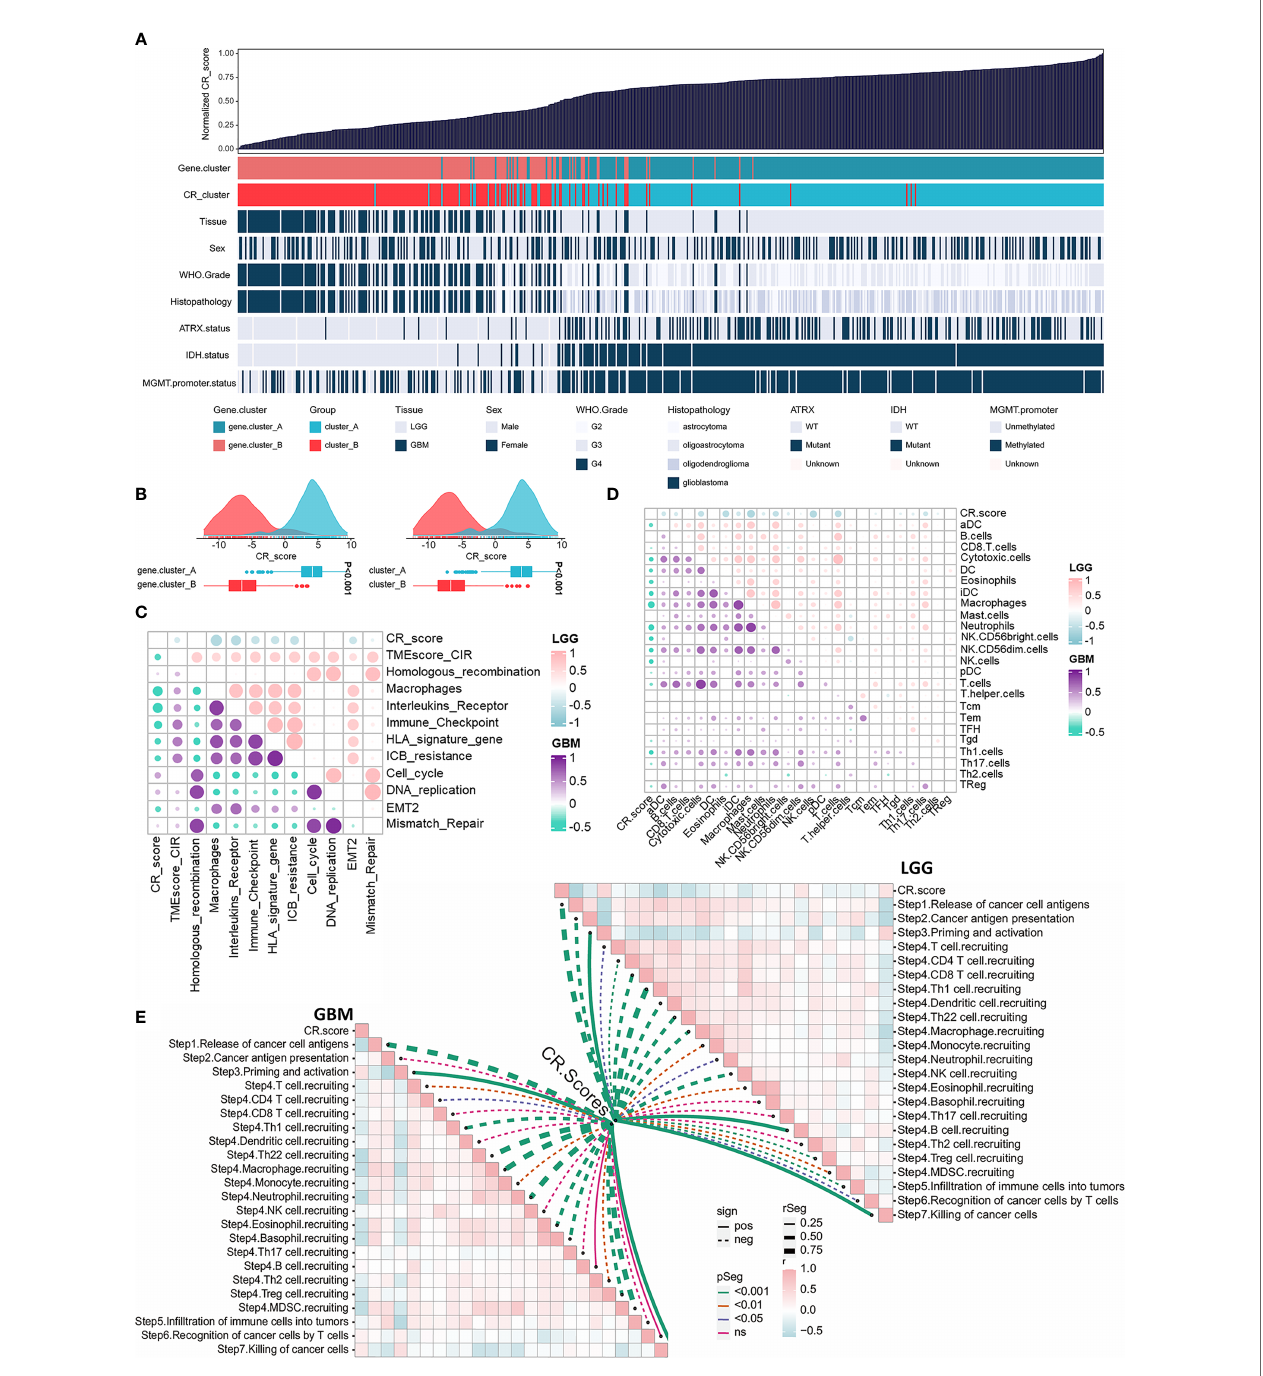
FIGURE 5 | Construction of the CRscore and exploration of its immunological relevance. (A) An overview of the association between CRscores and other patient annotations in TCGA cohort. (B) Comparison of CRscores between gene cluster A and B in the TCGA cohort, p < 0.001 (left); Comparison of CRscores between CR cluster A and B in the TCGA cohort, p < 0.001 (right). (C) The correlations between CRscore and TME relevant signatures in LGG as well as GBM of TCGA cohort, respectively ( p > 0.05). Pink represented positive correlation and blue represented negative correlation in LGG; purple represented positive correlation and green represented negative correlation in GBM. (D) The correlations between CRscore and ssGSEA scores of TME cells in LGG as well as GBM of the TCGA cohort, respectively ( p > 0.05). Pink represented positive correlation and blue represented negative correlation in LGG; purple represented positive correlation and green represented negative correlation in GBM. (E) The correlations between CRscore and steps of the cancer immunity cycle in LGG (right) as well as GBM (left) of TCGA cohort,